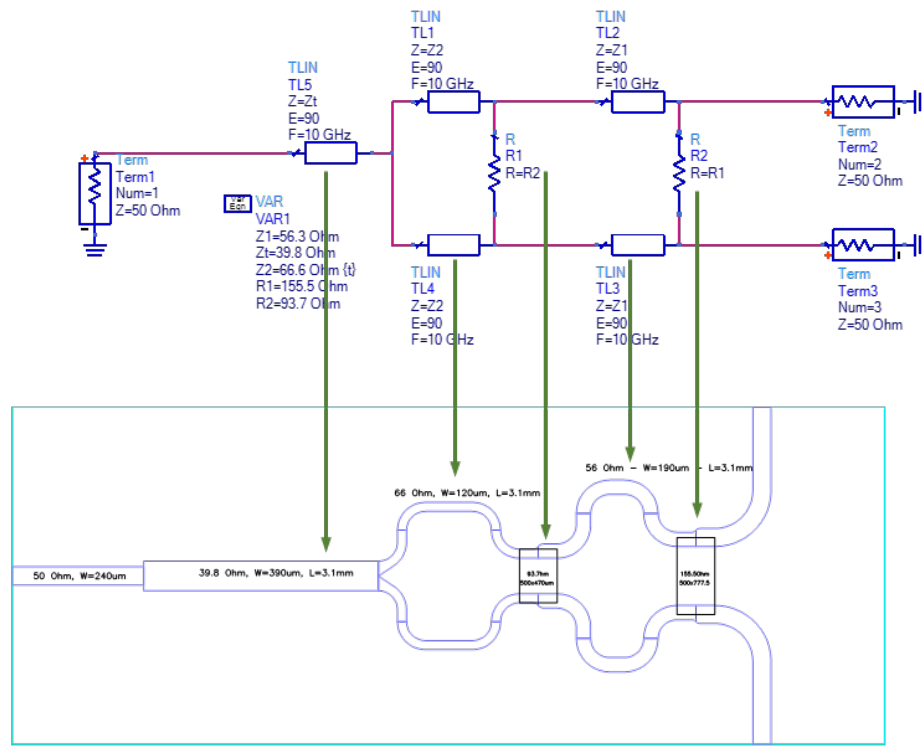
Figure 8. Overview of the equivalent circuit model and the corresponding layout within the full-wave simulator.